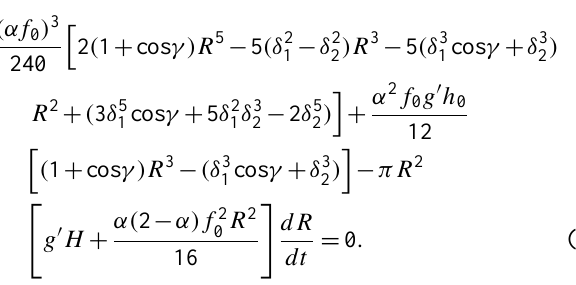
Fig. 3. Schematic diagram of the Concave I case: a zonal western shoreline segment with a slanted coastline ( γ = 0 to 90 ° ) to the east. The hatch marks indicate land. E is the center of the base eddy. The incoming flux Q flows along the wall, and the outgoing (retroflected) flux q is directed to the east. The widths of the currents are d 1 and d 2 , respectively. The “wiggly” arrows indicate the migration of the base eddy; this migration results from both the eddy growth, which forces the eddy away from the zonal wall, and from β , which forces the eddy along this wall. The migration velocity component − C y (t) is primarily due to eddy growth, whereas − C x (t) is primarily due to β . The thick grey line (with arrows) indicates the integration path, ABCDA; ˜h is the upper layer thickness of the stagnant region wedged between the upstream and retroflecting currents, and H is the off-shore thickness. The ring forms downstream of A 2 and immediately starts migrating westward. Consequently, the integrated momentum flux along the slanted wall involves an unknown force acting on the wall (and therefore cannot be used) but the zonal integrated momentum does not.